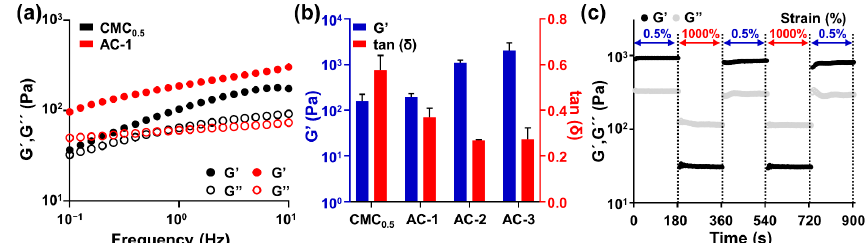
Figure 2. Rheological characterization of the AC hydrogel with different concentrations of CMC. ( a ) Oscillation frequency sweep measurements of CMC 0.5 (black) and AC-1 (red) hydrogels. The filled circles represent the storage modulus (G’), and the empty circles represent the loss modulus (G’’). ( b ) Comparison of the storage modulus and tan( δ ) values among CMC 0.5 , AC-1, AC-2, and AC-3. ( c ) Disruption and recovery of the storage (G’) and loss (G”) moduli of AC-3 hydrogels under alternat- ing strains of 0.5% and 1000%.